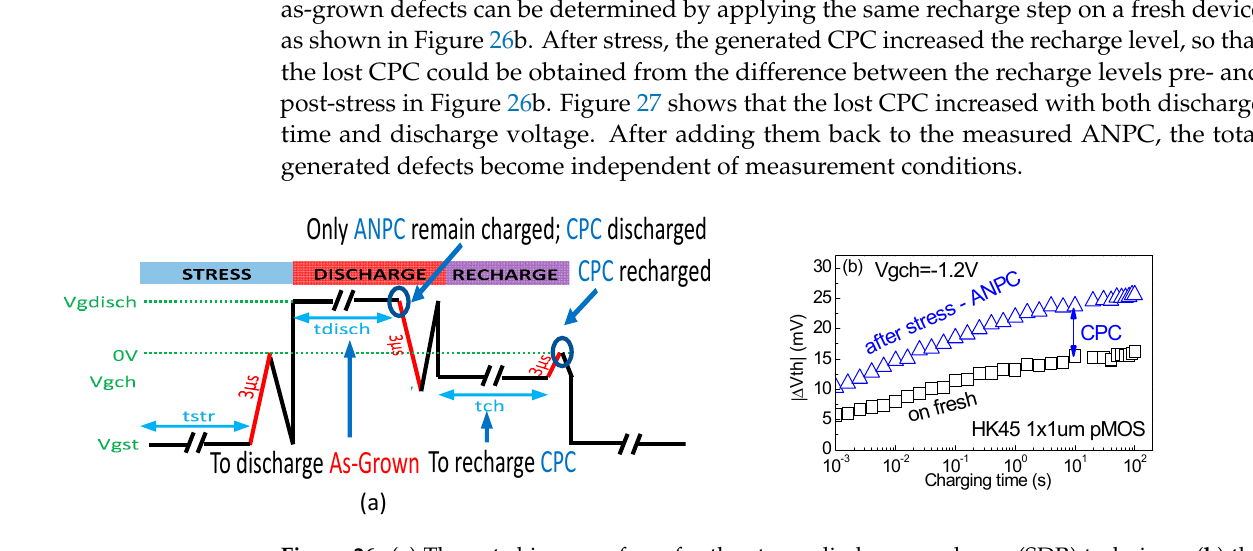
Figure 26. ( a ) The gate bias waveform for the stress–discharge–recharge (SDR) technique; ( b ) the recharge step: the increased | ∆ Vth| after stress from that of a fresh device was caused by the generated CPC [38].